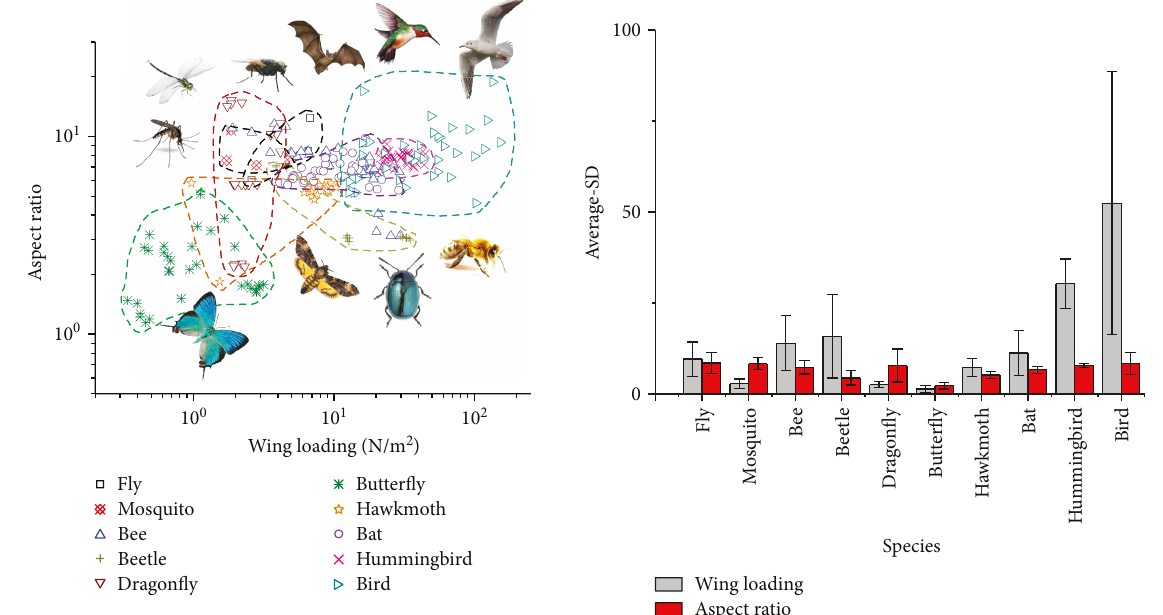
Figure 1: Aspect ratio vs. wing loading in natural fl yers (left), and average value with standard deviation (SD) of wing loading and aspect ratio